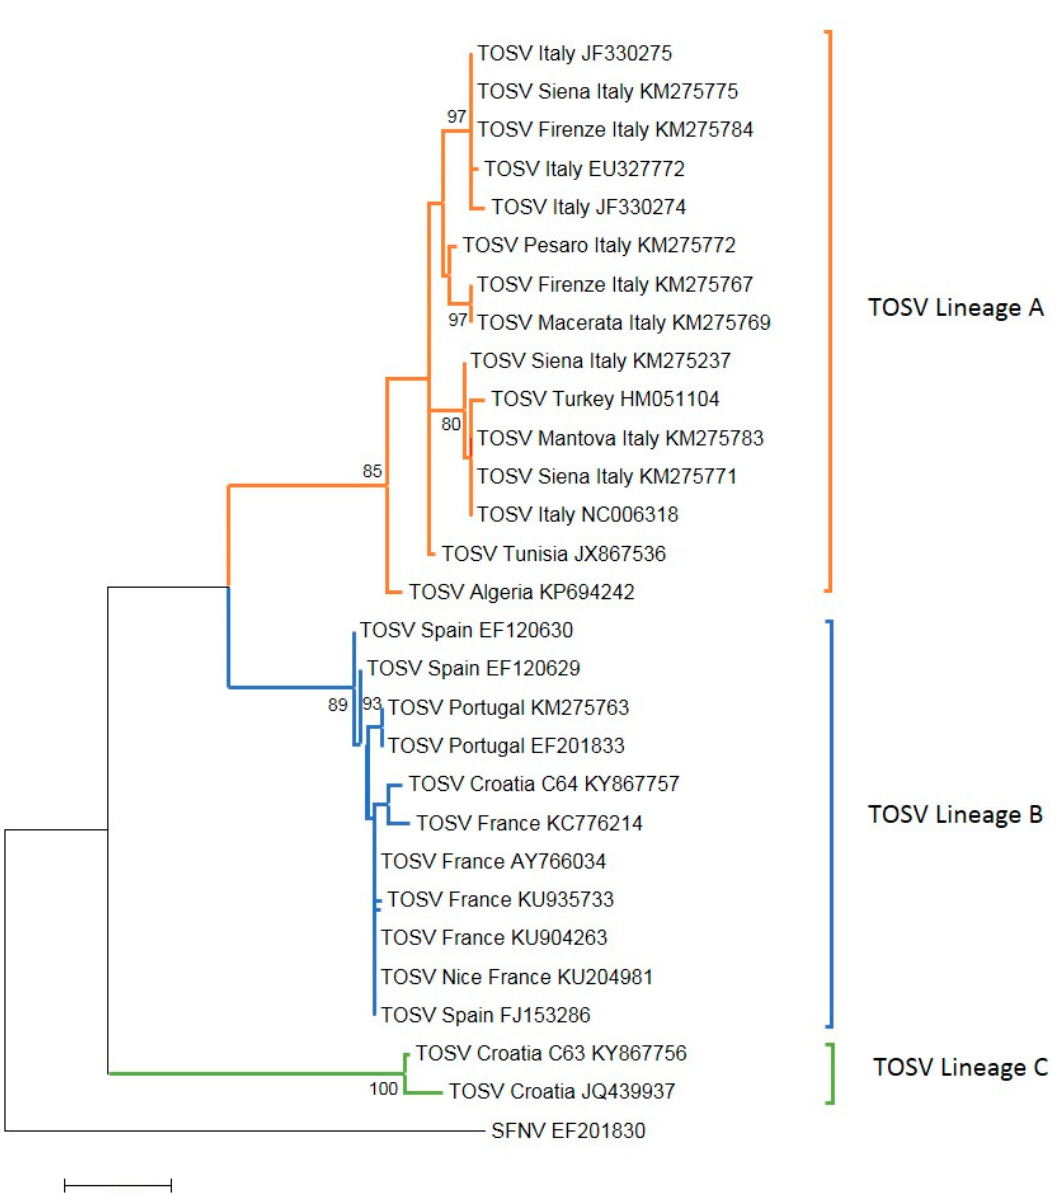
Figure 1. Phylogenetic analysis of Toscana virus (TOSV) based on the nucleocapsid protein gene. Maximum likelihood analysis at nucleotide level was performed using the MEGA 6.06 software program [15]. Bootstrap values are indicated and correspond to 1000 pseudoreplications.